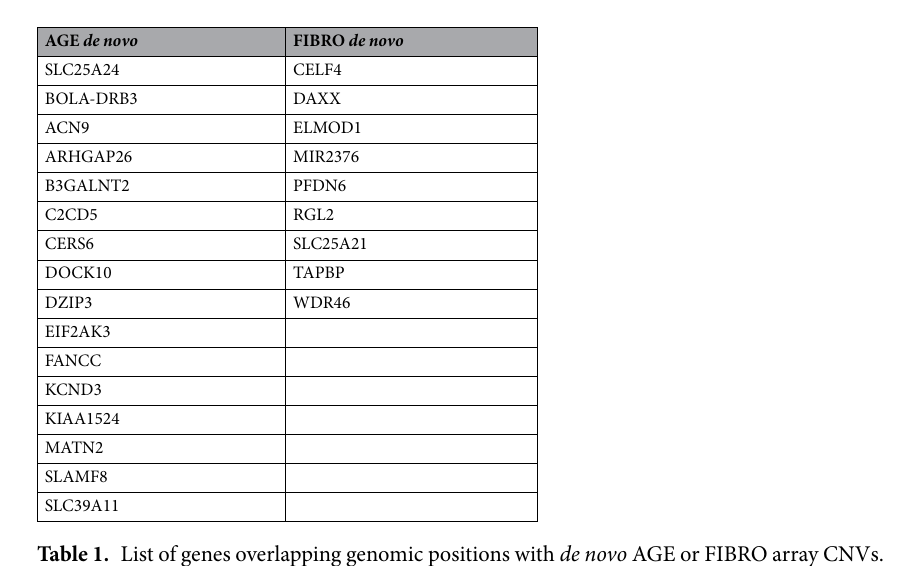
Table 1. List of genes overlapping genomic positions with de novo AGE or FIBRO array